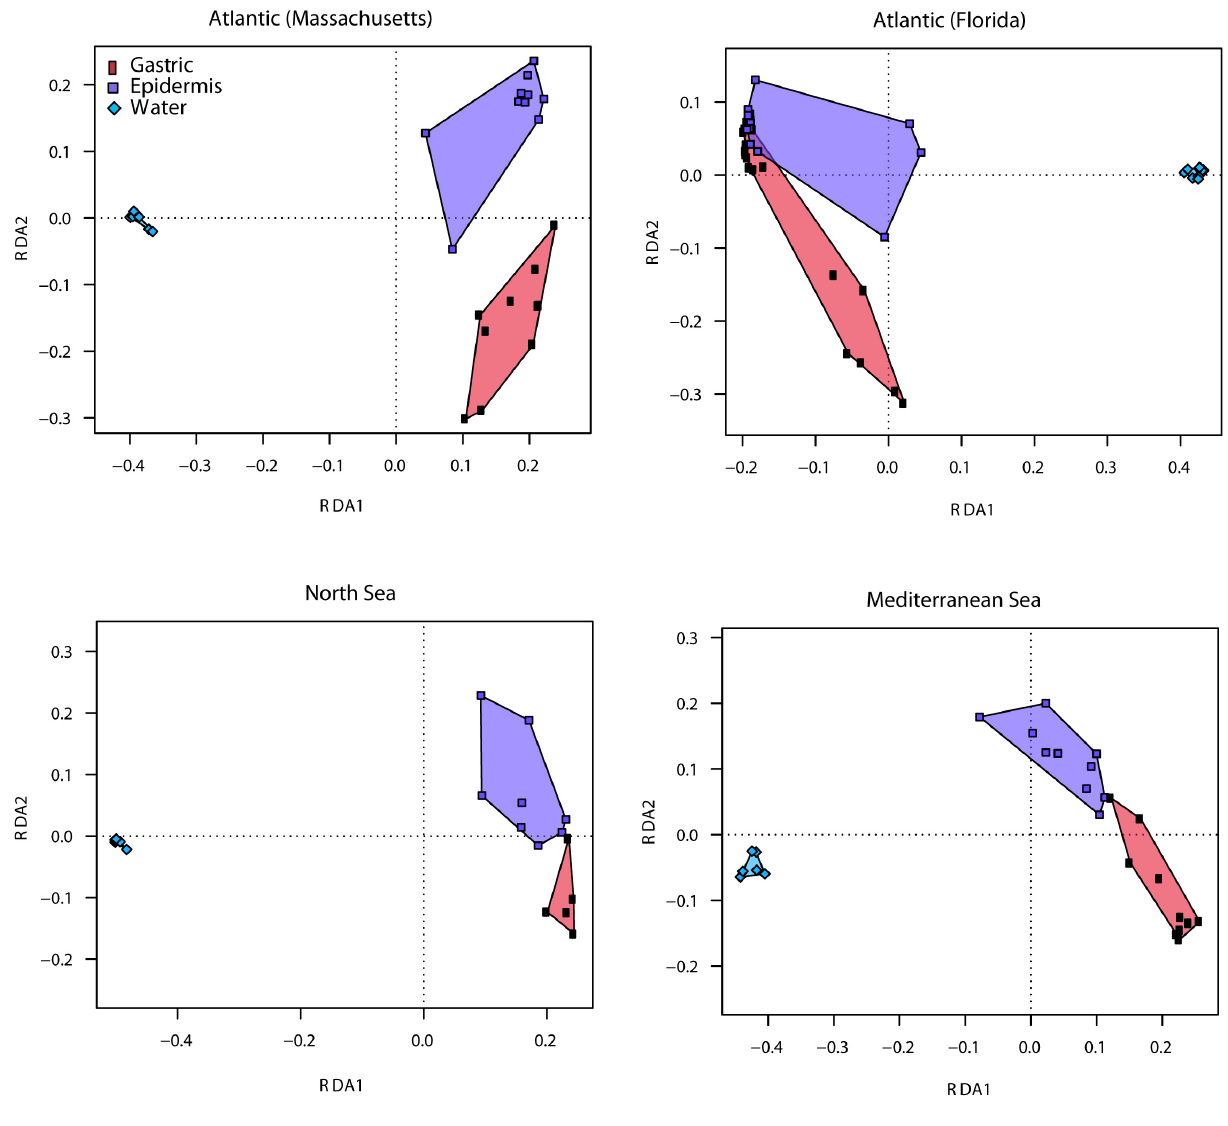
observed in abundances of main representatives and presence of different low abundant